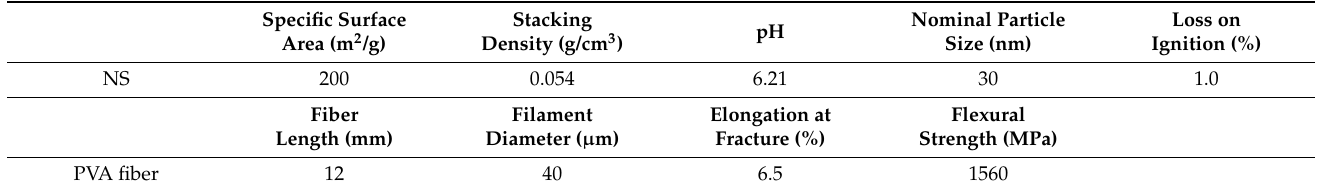
Table 1. Properties of NS and PVA fiber.